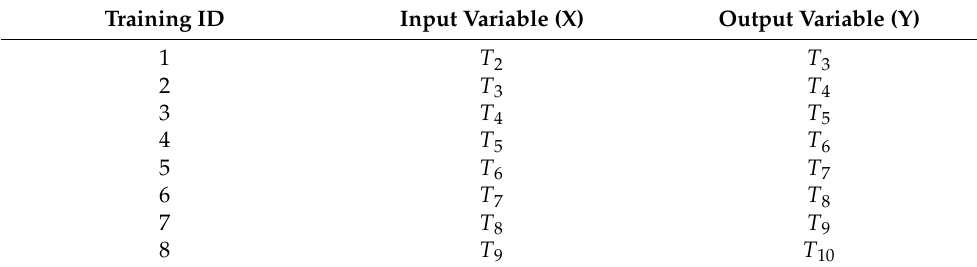
Table 2. An example of a training database without outliers.